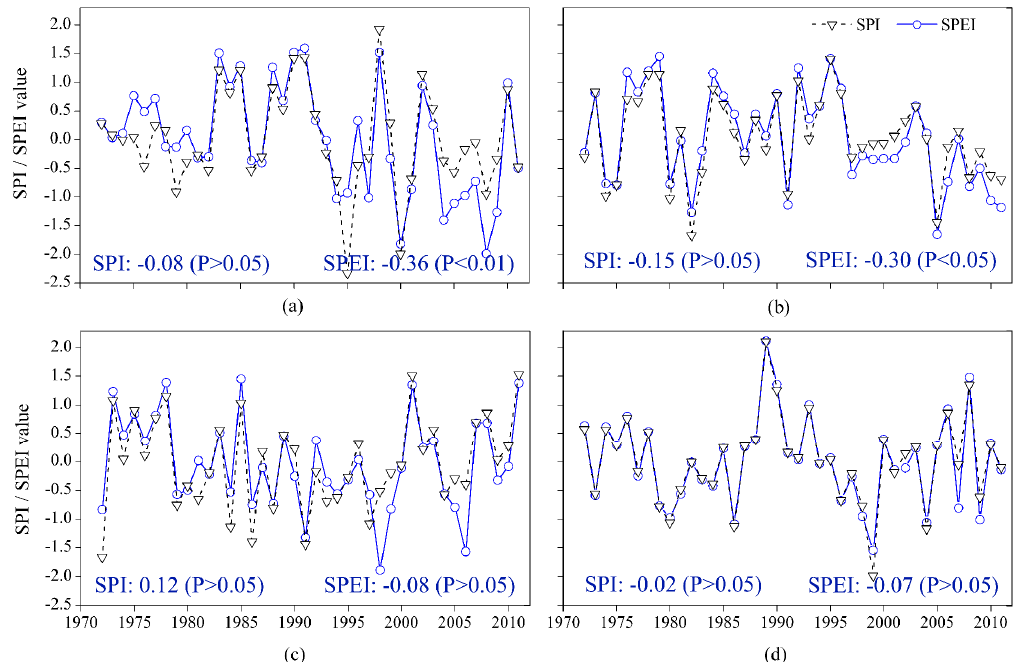
Figure 2. Annual variation of regional average SPI and SPEI values at the 12-month time scale in Ningxia during years 1972–2011 (Blue font denotes the M–K trend per decade (including the statistical significance) in the SPI/SPEI series).